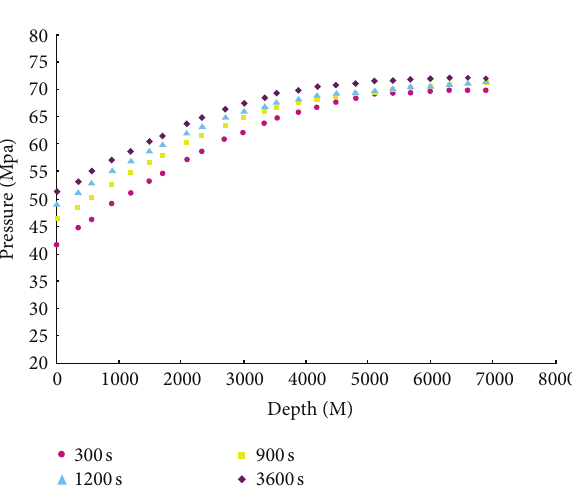
Figure 7: Pressure distribution at different